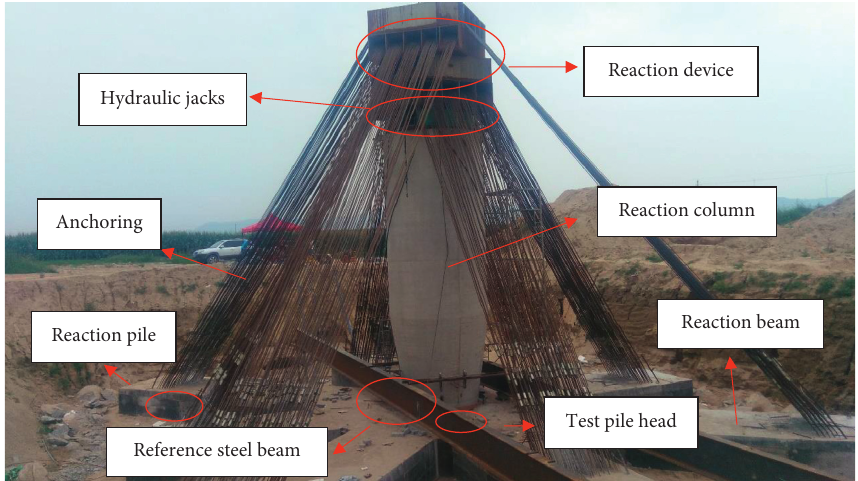
Figure 3: Anchoring reaction